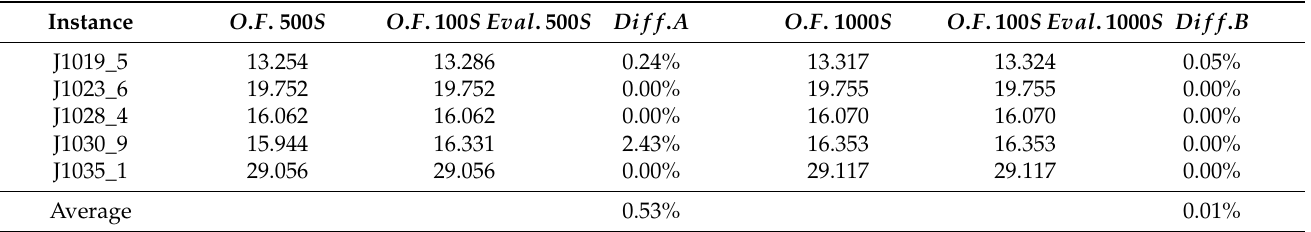
Table 15. Experiment 4 results. Evaluation of the 100 scenarios solution in the 500 and 1000 scenarios. Ten activities instances.